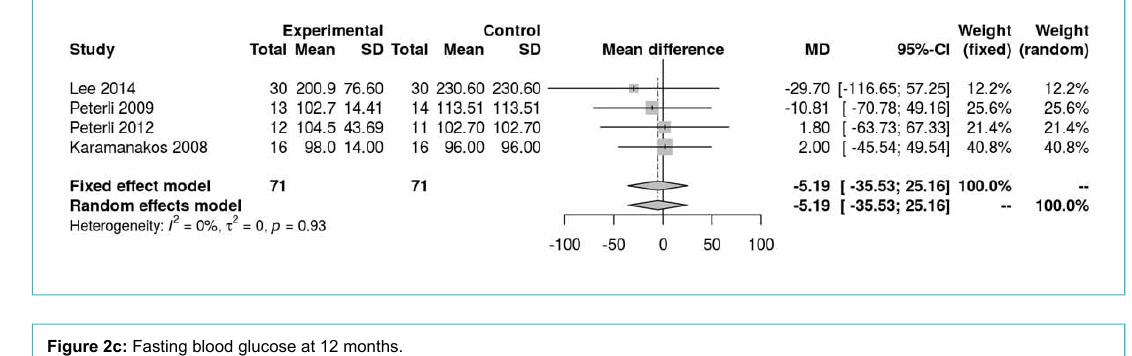
Figure 2c: Fasting blood glucose at 12 months.